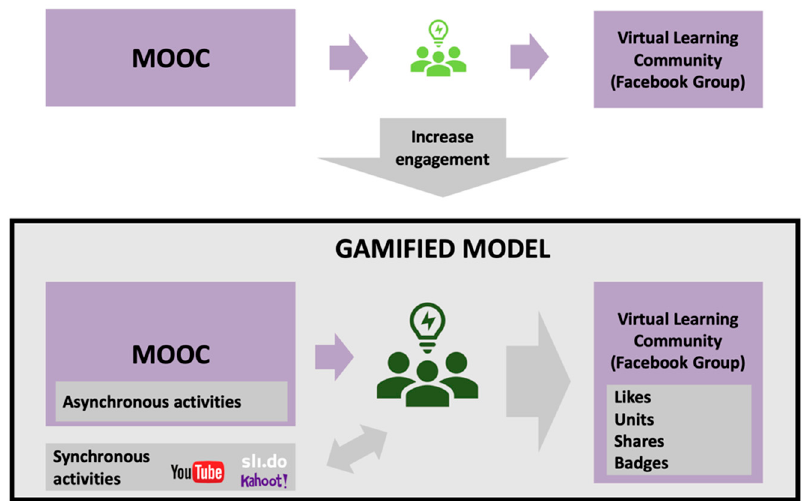
Figure 3. Gamifiedmodel(MassiveOpenOnlineCourses(MOOC)andVirtualLearningCommunities(VLC)). Figure 3. Gamified model (Massive Open Online Courses (MOOC) and Virtual Learning Communities (VLC)).